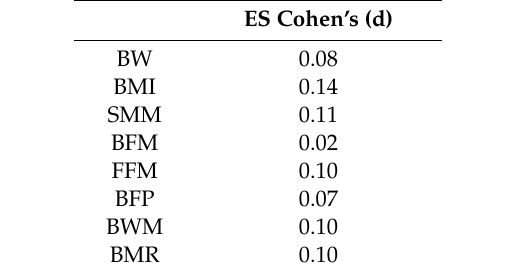
Table 6. Cohen’s ES (d) of BC parameters of all participants between T1 and T3.